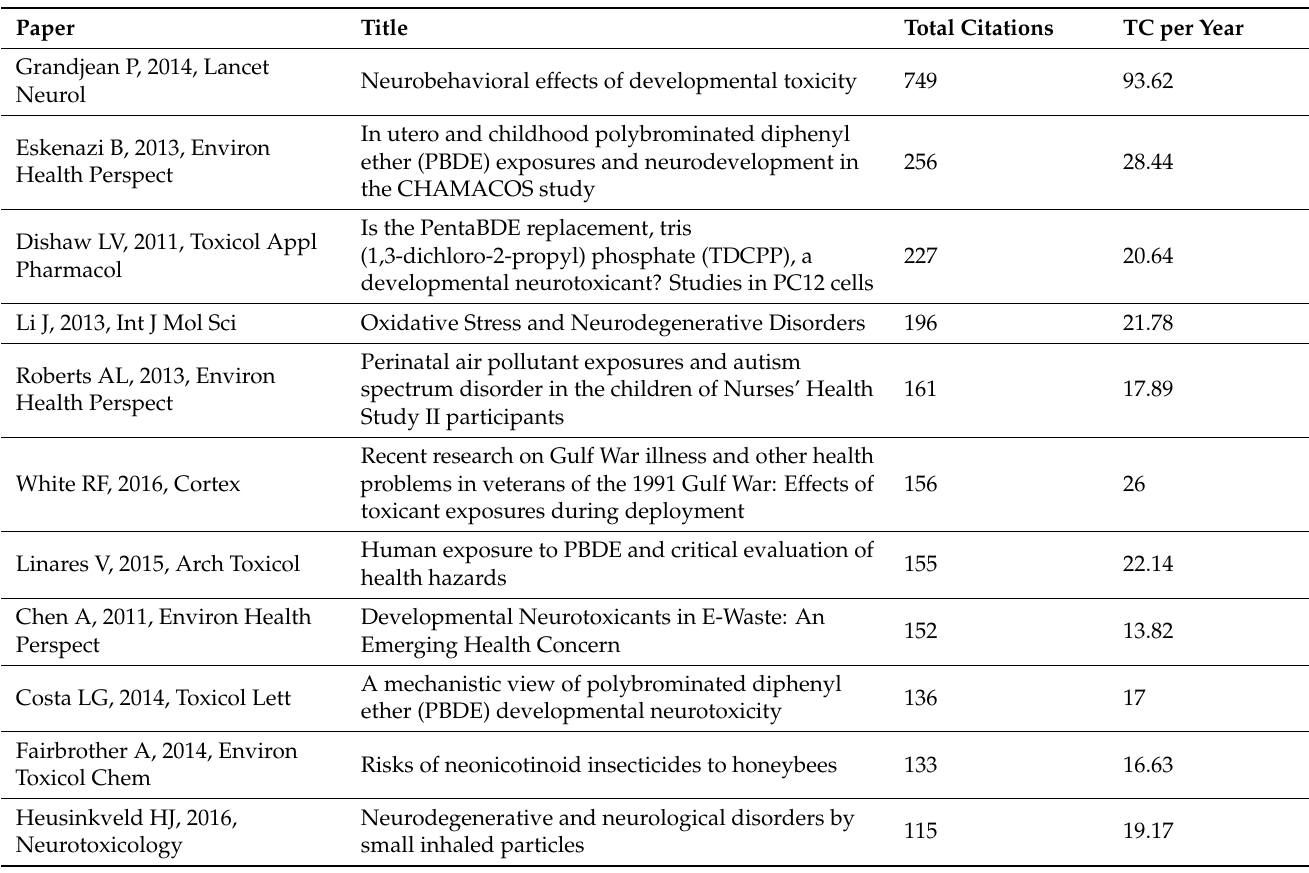
Table 5. Most globally cited documents between 2011 and